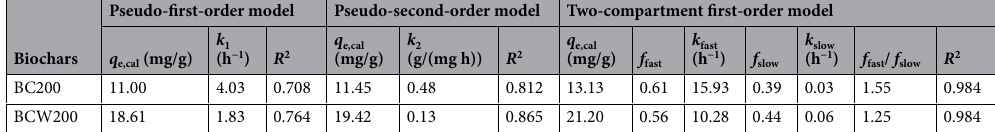
Pseudo-first-order model Pseudo-second-order Biochars